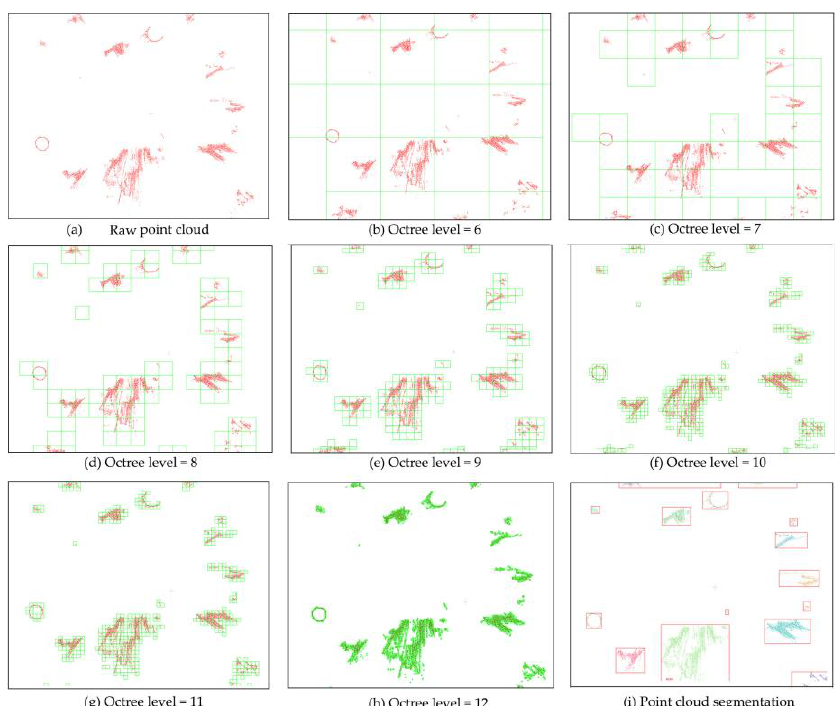
Figure 5. Processing of octree segmentation and connected component labeling (top view). ( a ) Raw point cloud with shrubs and weeds; ( b – h ) With the increasing depth of octree, the points are divided into independent spaces relatively; ( i ) The point cloud is divided into different parts (represented by different colors), and randomly taking points within a single area can effectively reduce the invalid